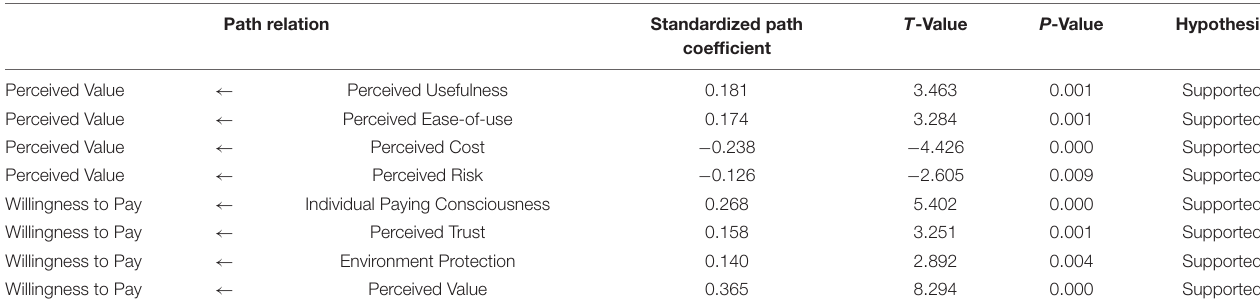
FIGURE 4 | Modified structural equation analysis model. TABLE 6 | Hypothesis test